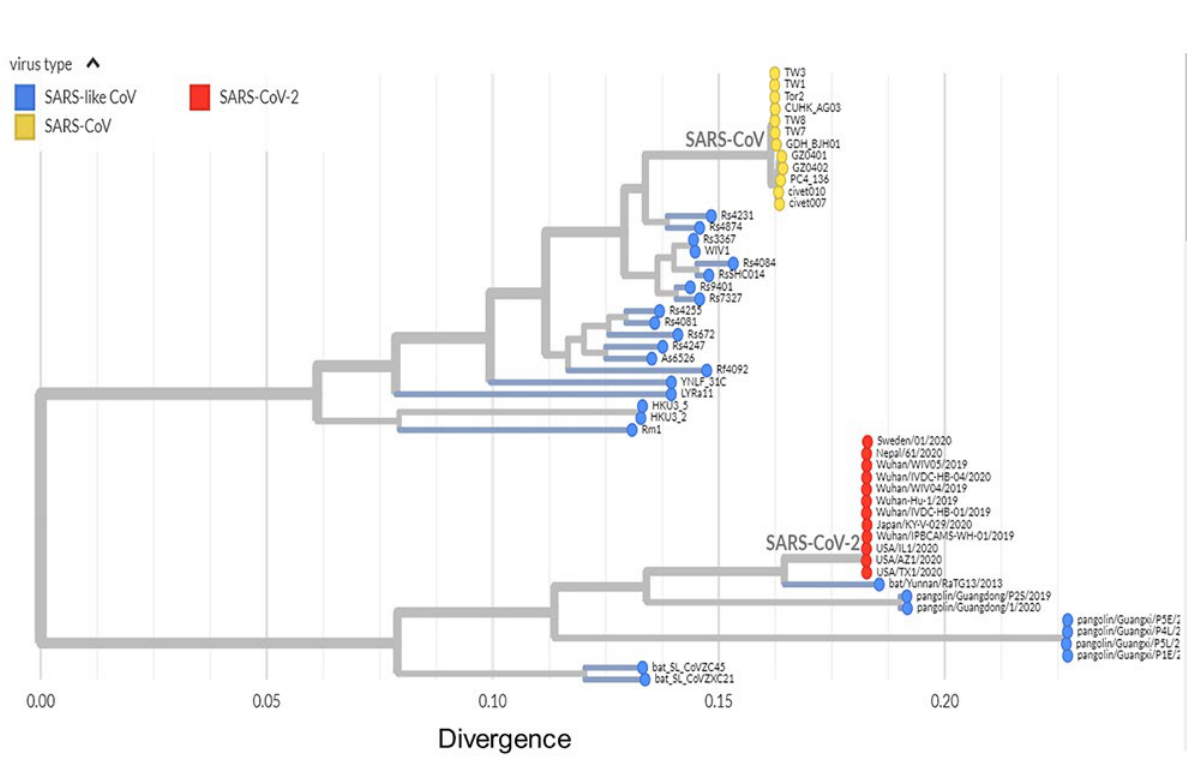
Phylogenetic tree including 52 genomes. Red dots, SARS-CoV-2 coronaviruses from the COVID-19 epidemic; yellow dots, SARS-CoV coronaviruses from the 2002- 03 SARS outbreak; and blue dots, SARS-like coronaviruses. Adapted from “github.com/blab/sars-like-cov”; “Built with blab/sars-like-cov and maintained by Trevor Bedford and Emma